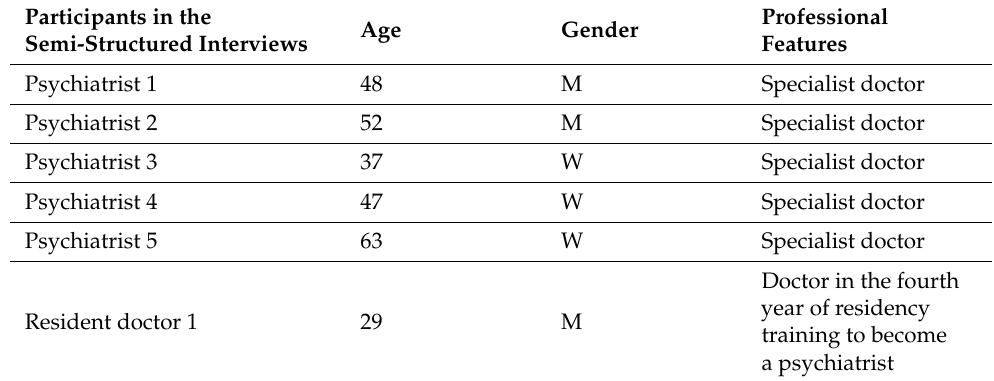
Table 3. Individual characteristics of the participants in the semi-structured interviews